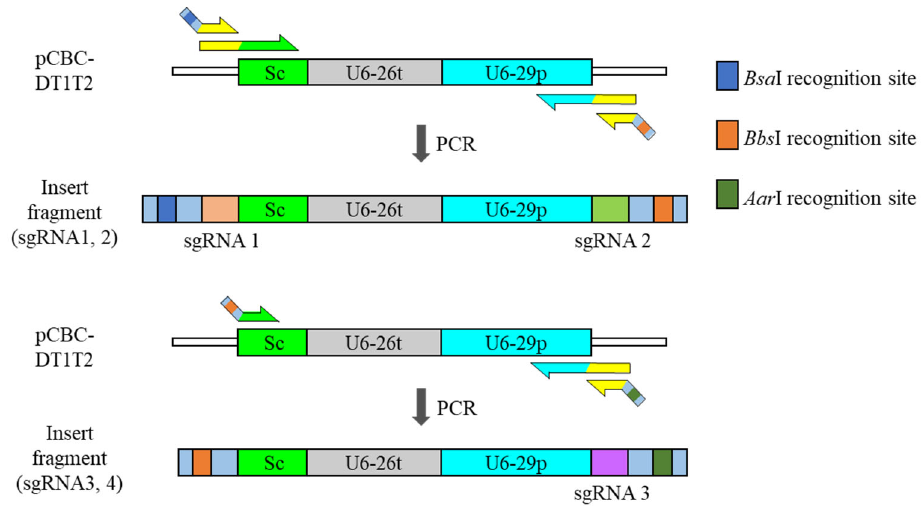
Figure 1. Schematic structure of each insert for pHEE401E ligation. Addition of fourth sgRNA is made possible by the switch restriction-enzyme-recognition site of Bbs I and Aar I. Sc; sgRNA scaffold, U6 ‐ 26t; U6 ‐ 26 terminator, U6 ‐ 29p; U6 ‐ 29 promoter.